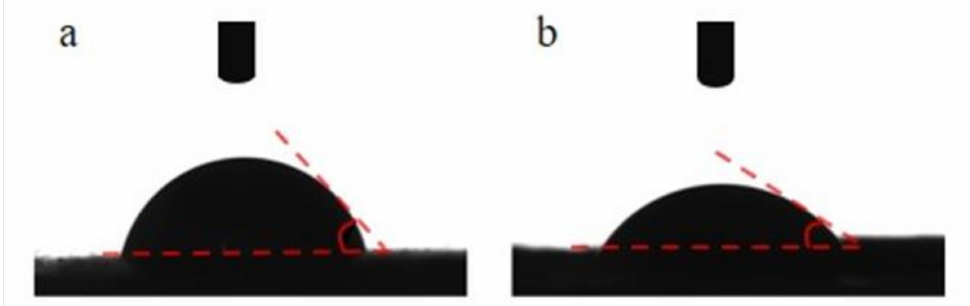
Figure 6. Contact angle. ( a ) Before PEO removal, ( b ) After PEO